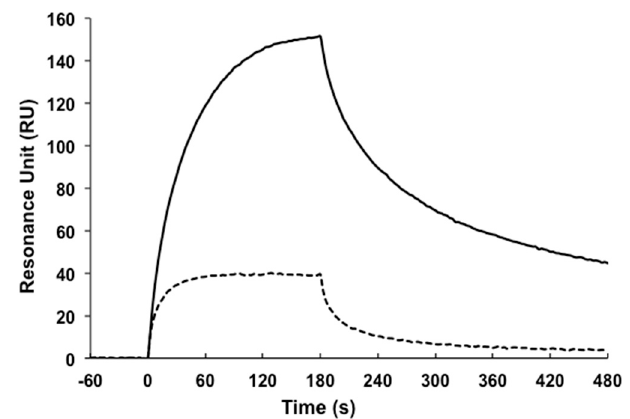
Figure 5. SPR analysis of the binding affinity of AGE73scFv. The binding affinity of AGE73scFv for the peptide containing GA-pyridine was measured at 25 °C (solid line) and 37 °C (dashed line).